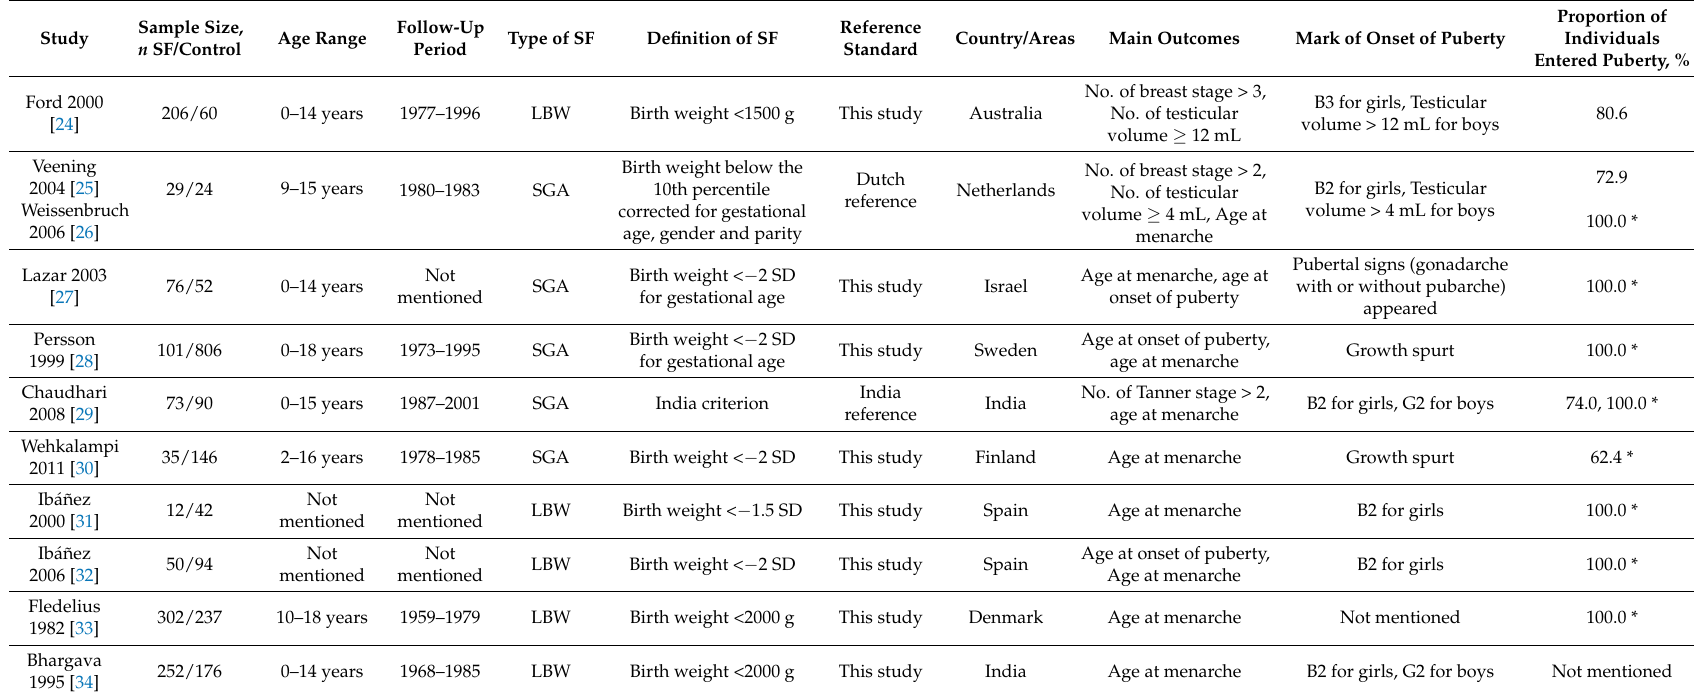
Table 1. Characteristics of studies included in the systematic